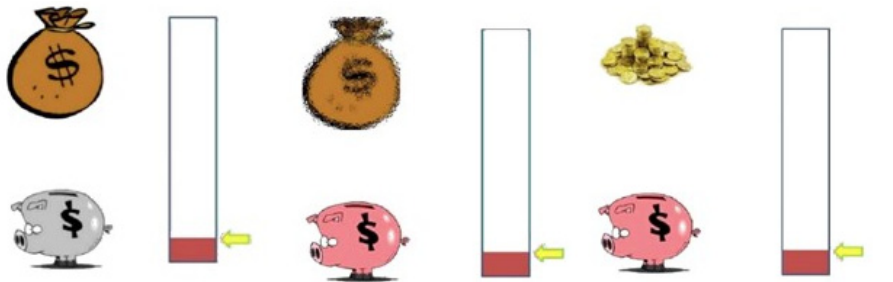
Figure 1. The Pinky-Piggy videogame application is based on autoshaping, a classical experimental procedure in animal models. The CS (a lever in the rat procedure) is turned into a colorful and attractive pig and money bag. The bag starts shaking after 4 s, becoming more noticeable. The US (money coins) is shown after the bag presentation. For each trial, the CS is displayed for 8 s through 14 trials.